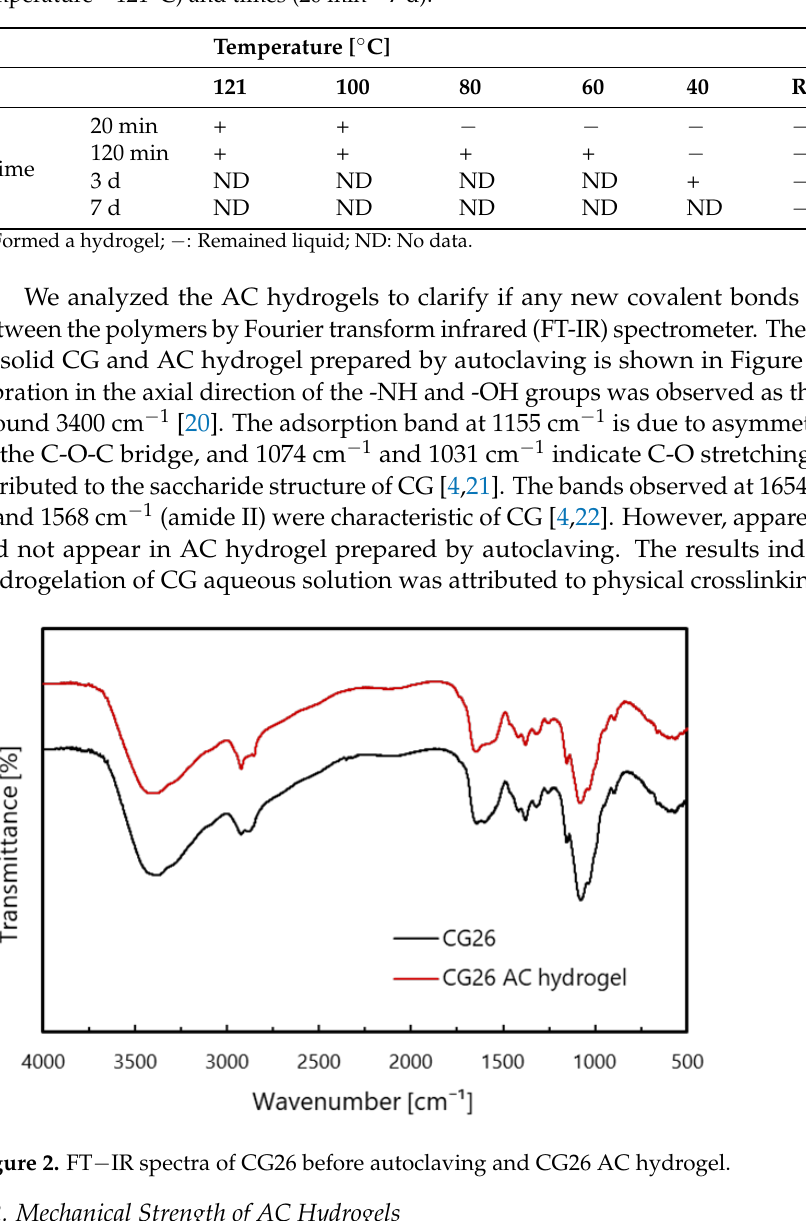
Table 2. Hydrogelation of CG26 aqueous solution by heating at various temperatures (room temperature — 121°C) and times (20 min — 7 d).